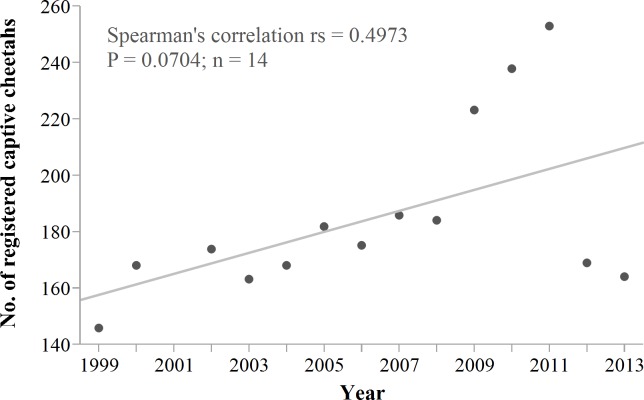
Namibia’s registered captive cheetah population 1999–2013.Trend line shows robust fit. The sudden drop in 2012/2013 probably is an effect of reduced reporting rather than an actual decrease in captive numbers. Data source: International Cheetah Studbook (1999–2013); Cheetah Conservation Fund, Otjiwarongo, Namibia.